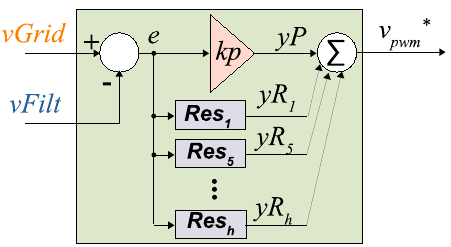
Figure 7. Proportional plus Resonant Controller —Redraw based on